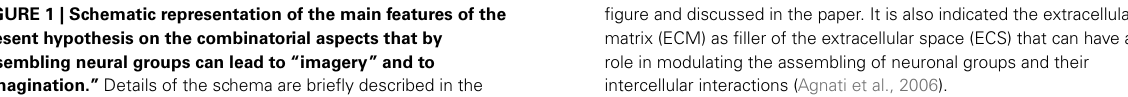
FIGURE 1 | Schematic representation of the main features of the present hypothesis on the combinatorial aspects that by assembling neural groups can lead to “imagery” and to “imagination.” Details of the schema are briefly described in the